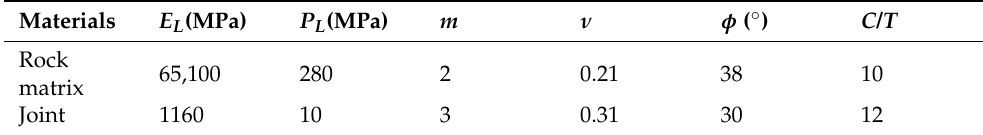
Table 2. Material properties of the CJRM FE model [58].